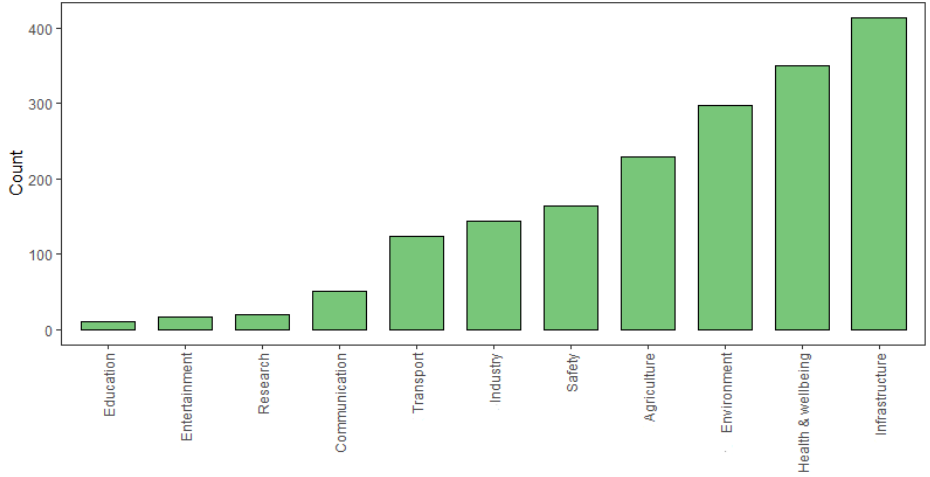
Figure 3. Sensor network deployment distribution by field of the goal network.